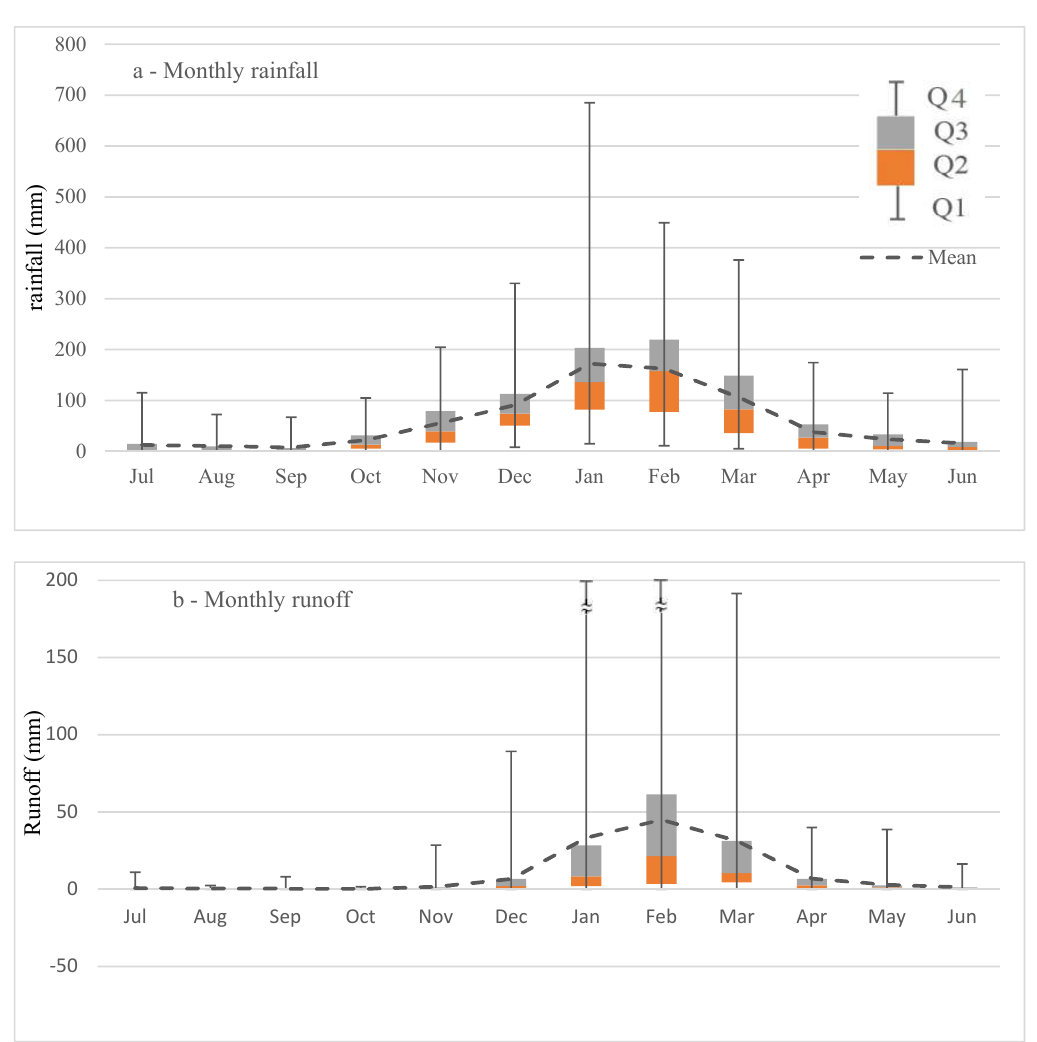
Figure 4. Annual rainfall–runoff relations in Upper Burdekin catchment above Sellheim ( a ); Basalt ( b ) and Keelbottom ( c ) gauge stations for the period of 1948–2016.